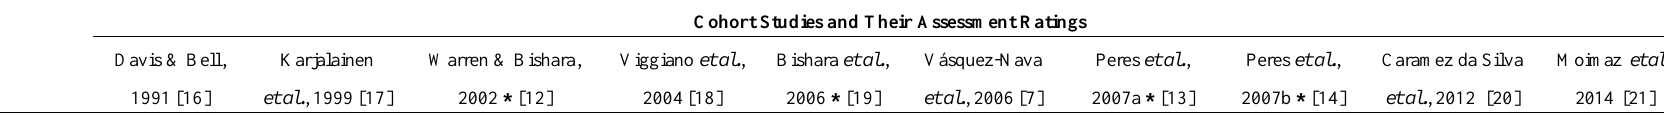
Table 1. Quality assessment criteria used for cohort studies through a modified version of Newcastle-Ottawa